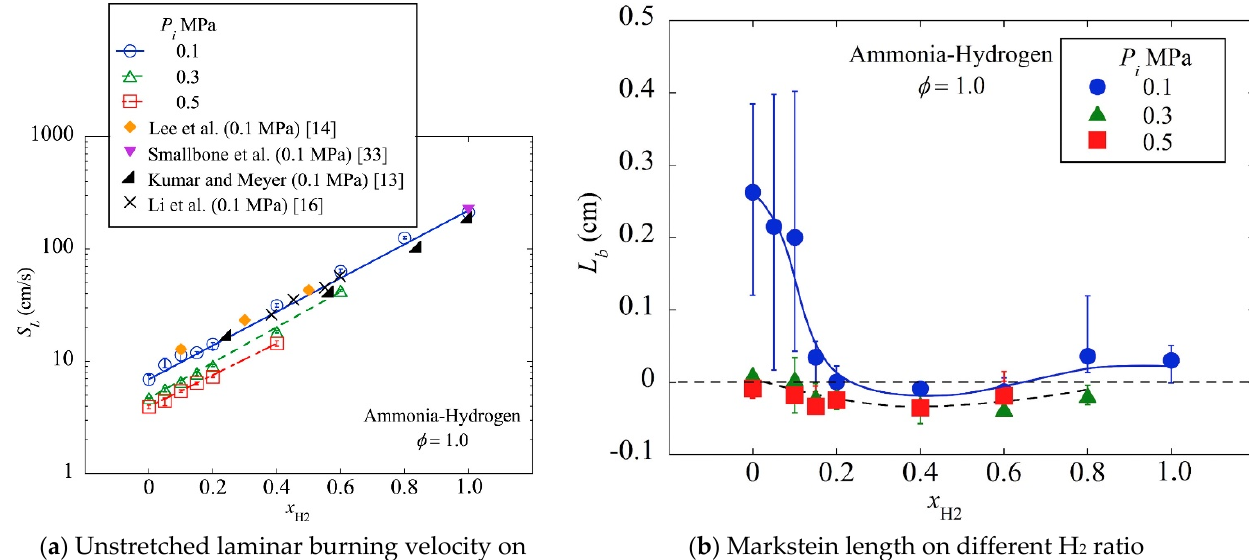
Figure 9. Burning velocity change due to H 2 addition to NH 3 : ( a ) Relationship between unstretched laminar burning velocity, S L , and hydrogen ratio, X H2 , in initial pressure varies from 0.1 to 0.5 MPa; ( b ) Relationship between the burned gas Markstein length, L b , and the H 2 ratio, X H2 . Courtesy of Elsevier [62].